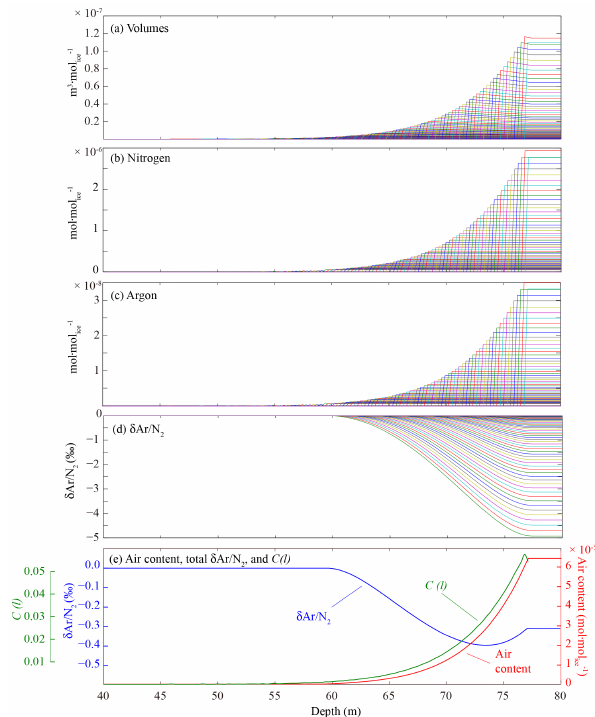
Figure 10. Traces of simulated δ Ar / N 2 changes for each annual layer for the normal bubbles. The model calculates bubble genera- tion for each annual layer, gas permeation into open air, and finally trapping into ice (see text). The model is calculated assuming an equilibrium state with a temperature of − 31 ◦ C, accumulation rate of 0.24miceyear − 1 , and microbubble contribution of 2% (same as for Fig. 9). (a) Changes in the volumes of the normal bubbles for each annual layer induced by density changes with depth. (b) Ni- trogen concentrations as in (a) . (c) Argon concentrations as in (a) . (d) δ Ar / N 2 as in (a) . (e) Air contents with depth, δ Ar / N 2 , and C(l) for the bulk of the normal bubbles (sum of the values in annual lay- ers for each depth). Different colors (a – d) indicate values for each annual layer, showing how the bubbles generated in different annual layers evolve with